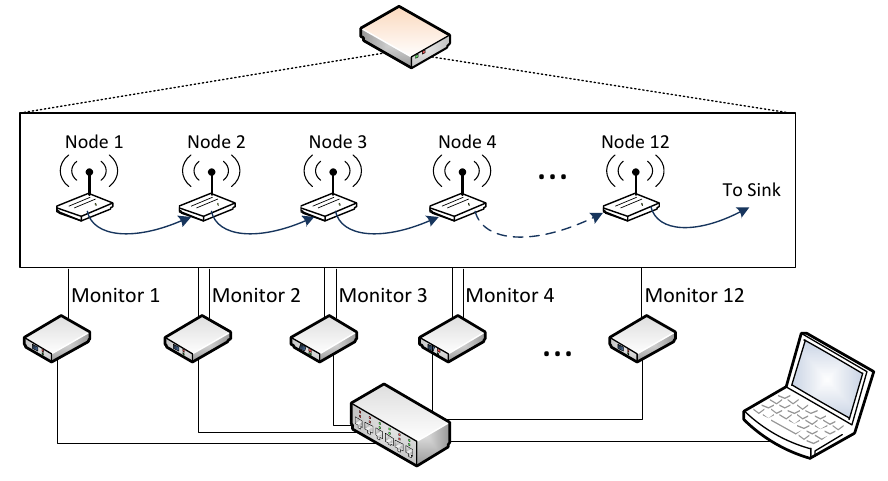
Figure 11. Scheme of the second experiment.